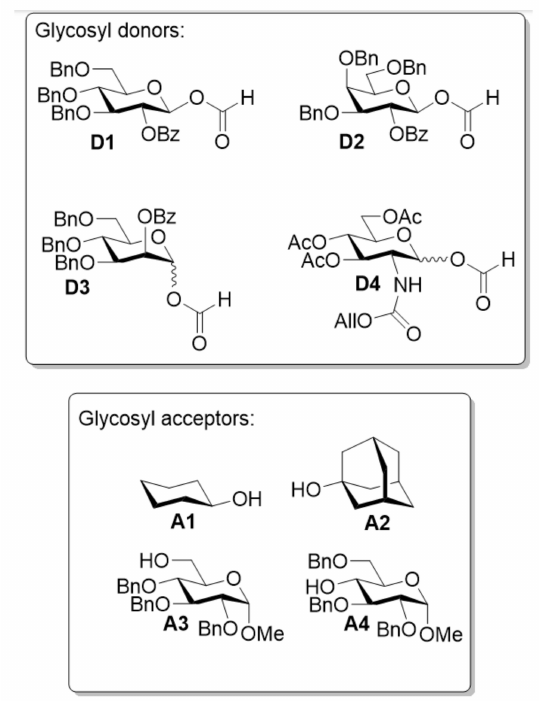
Figure 1. Glycosyl donors and acceptors used in this